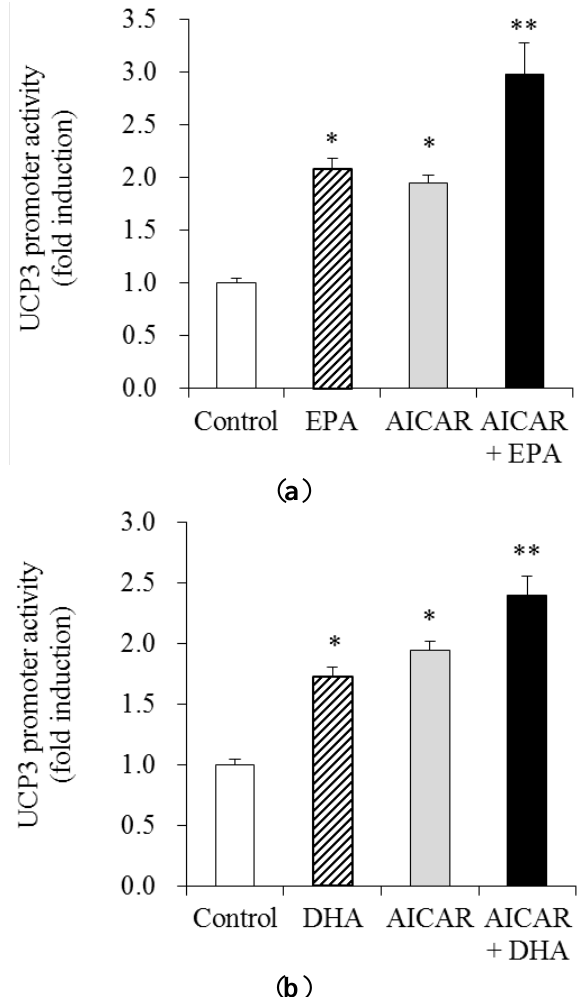
Figure 4. Effects of 5′-amino-4-imidazolecarboxamide-ribonucleoside (AICAR) on